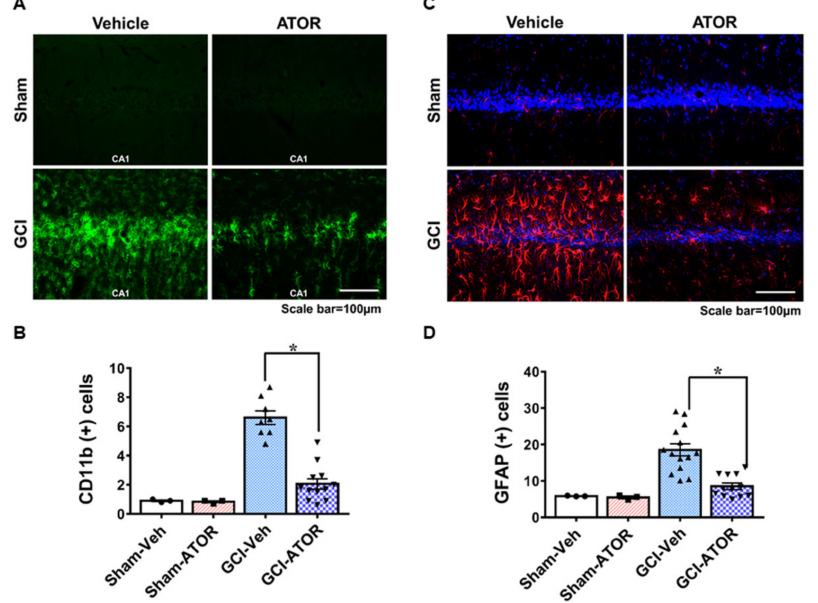
Figure 3. Atorvastatin reduces microglia and astrocyte activation after global cerebral ischemia. GCI induces an excessive inflammatory response by promoting microglia and astrocyte activation in the damaged area. The 1-week atorvastatin treatment prevented inflammation in CA1 following GCI. Activation of microglia ( A ) and astrocytes ( C ) in the sham-operated and GCI-induced rats. Scatter dot plot bar graphs represent the degree of microglia activation and the intensity of activated astrocytes in the CA1 region ( B , D ). Data are mean ± S.E.M., n = 3 for each sham group, n = 8 for each ischemia group. * Significantly different from the vehicle-treated group, * p <